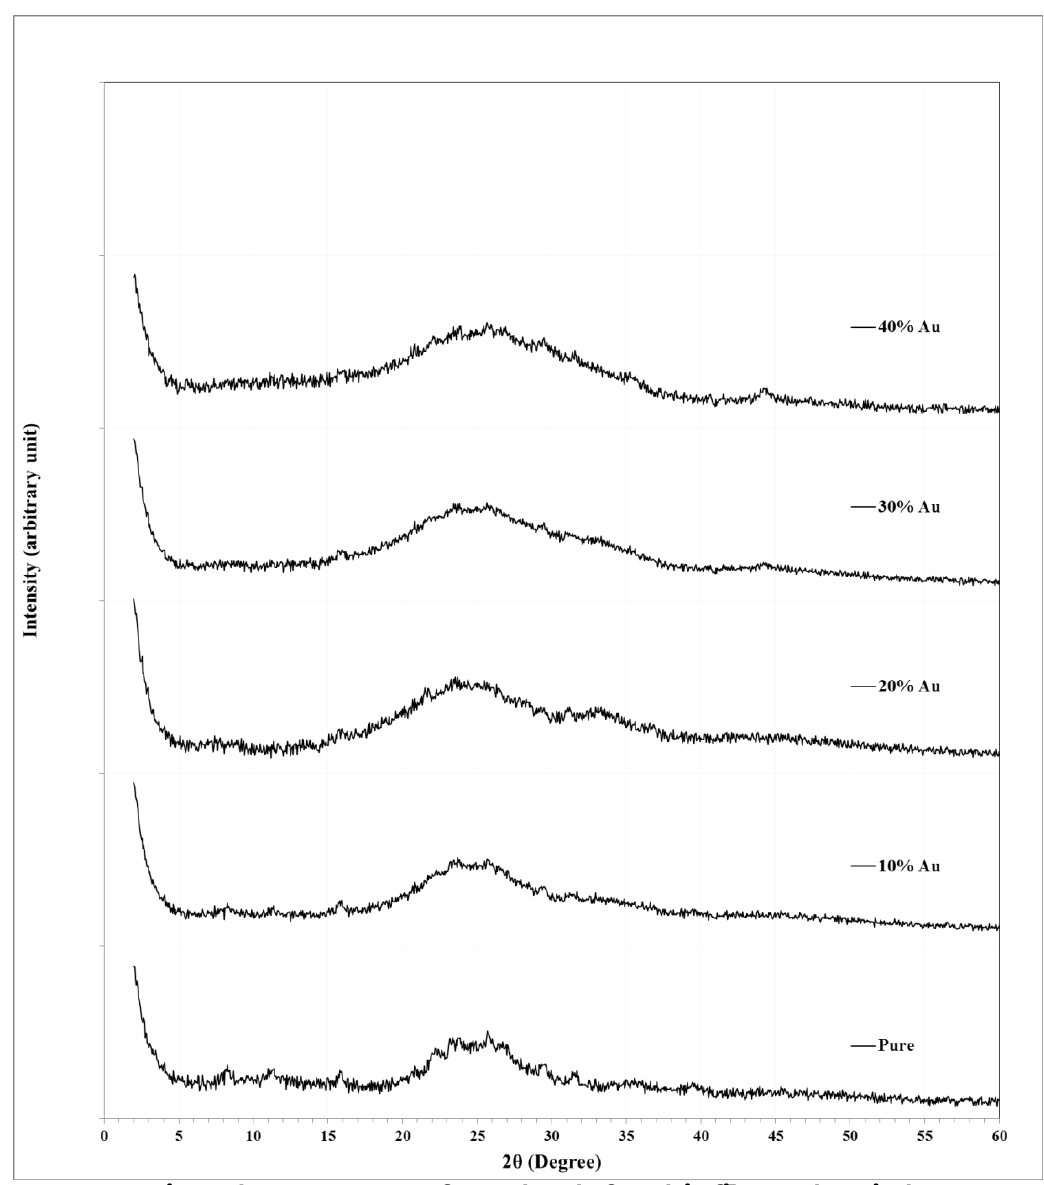
Fig.1: The XRD pattern of WO